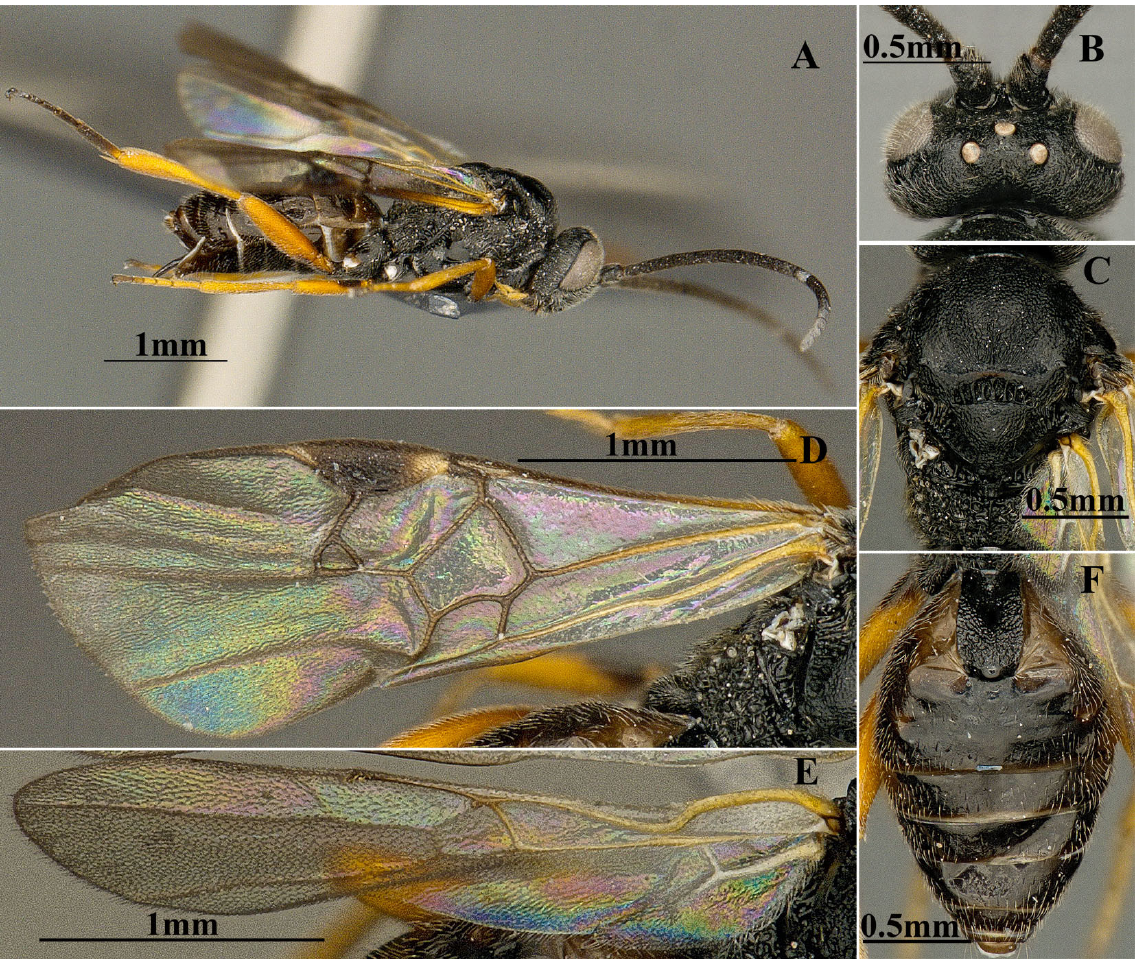
Fig. 2. Microplitis alborziensis Abdoli & Talebi sp. nov., holotype, ♀, TMUC-HBMMP0001. A . Habitus, lateral view. B . Head, dorsal view. C . Mesosoma, dorsal view. D . Fore wing. E . Hind wing. F . Metasoma, dorsal